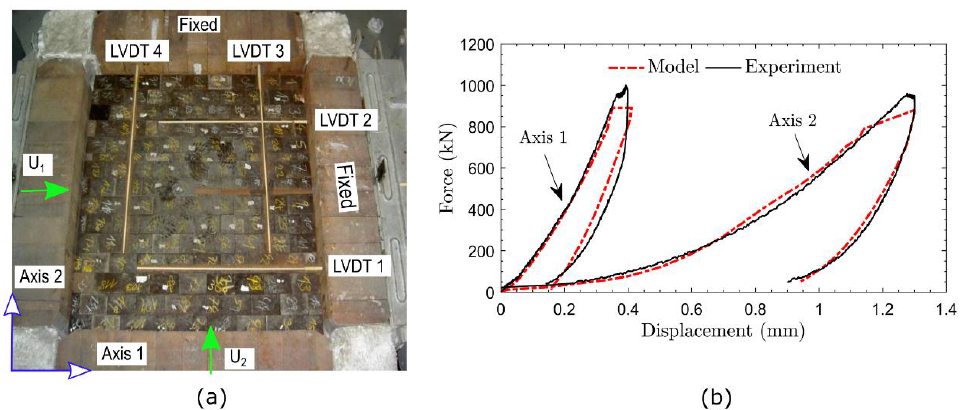
Figure 6. ( a ) Biaxial compression test setup [4] and ( b ) comparison between experimental and numerical results.